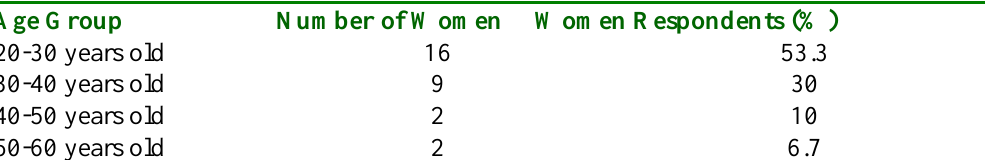
Table 2. Interviewees by Age-group Age